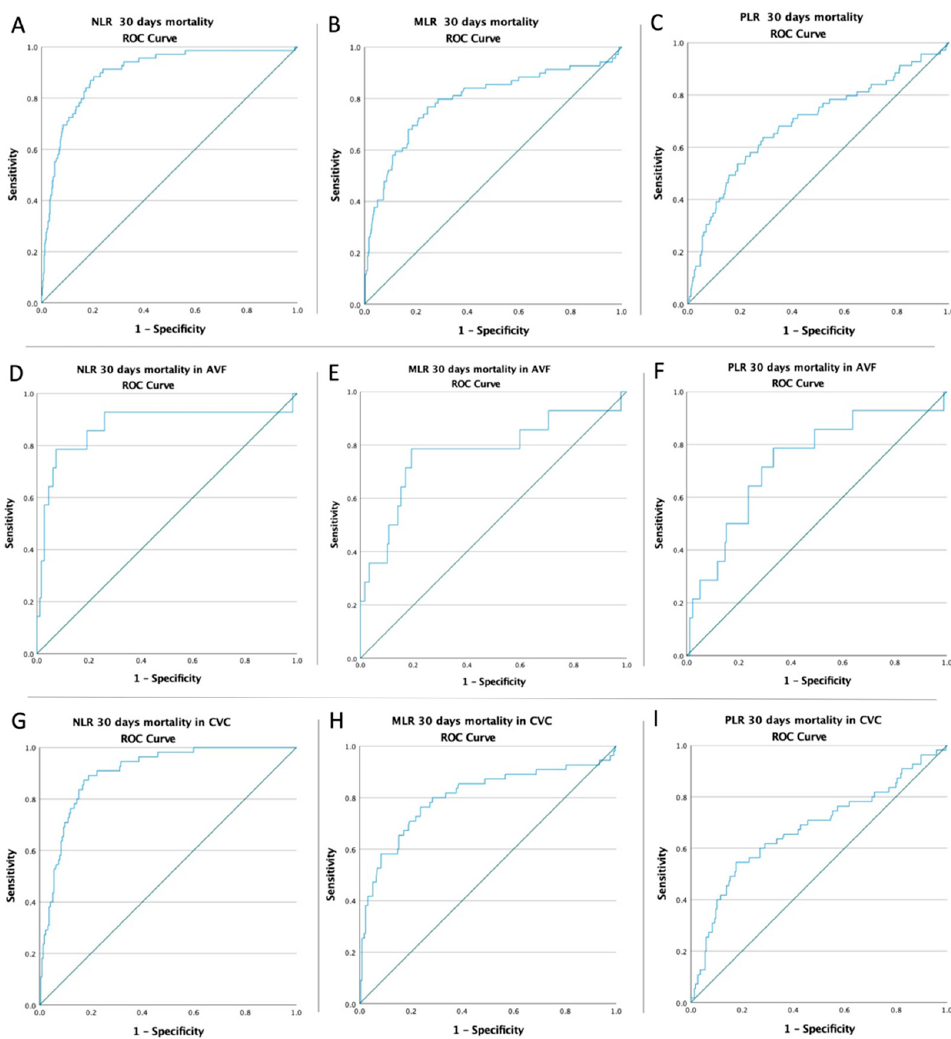
Figure 2. ROC curve analysis ( A ) for NLR concerning the mortality rate in all patients (AUC = 0.897; p < 0.0001), ( B ) for MLR concerning mortality in all patients (AUC = 0.792; p < 0.0001), ( C ) for PLR concerning mortality rate in all patients (AUC = 0.692; p < 0.0001), ( D ) for NLR concerning mortality in AVF patients (AUC = 0.837; p < 0.0001), ( E ) for MLR concerning mortality in AVF patients (AUC = 0.753; p = 0.001), ( F ) for PLR concerning mortality in AVF patients (AUC = 0.709; p = 0.008), ( G ) for NLR concerning the mortality rate in CVC patients (AUC = 0.887; p < 0.0001), ( H ) for MLR concerning the mortality rate in CVC patients (AUC = 0.783; p < 0.0001), ( I ) for PLR concerning the mortality rate in CVC patients (AUC = 0.674; p <